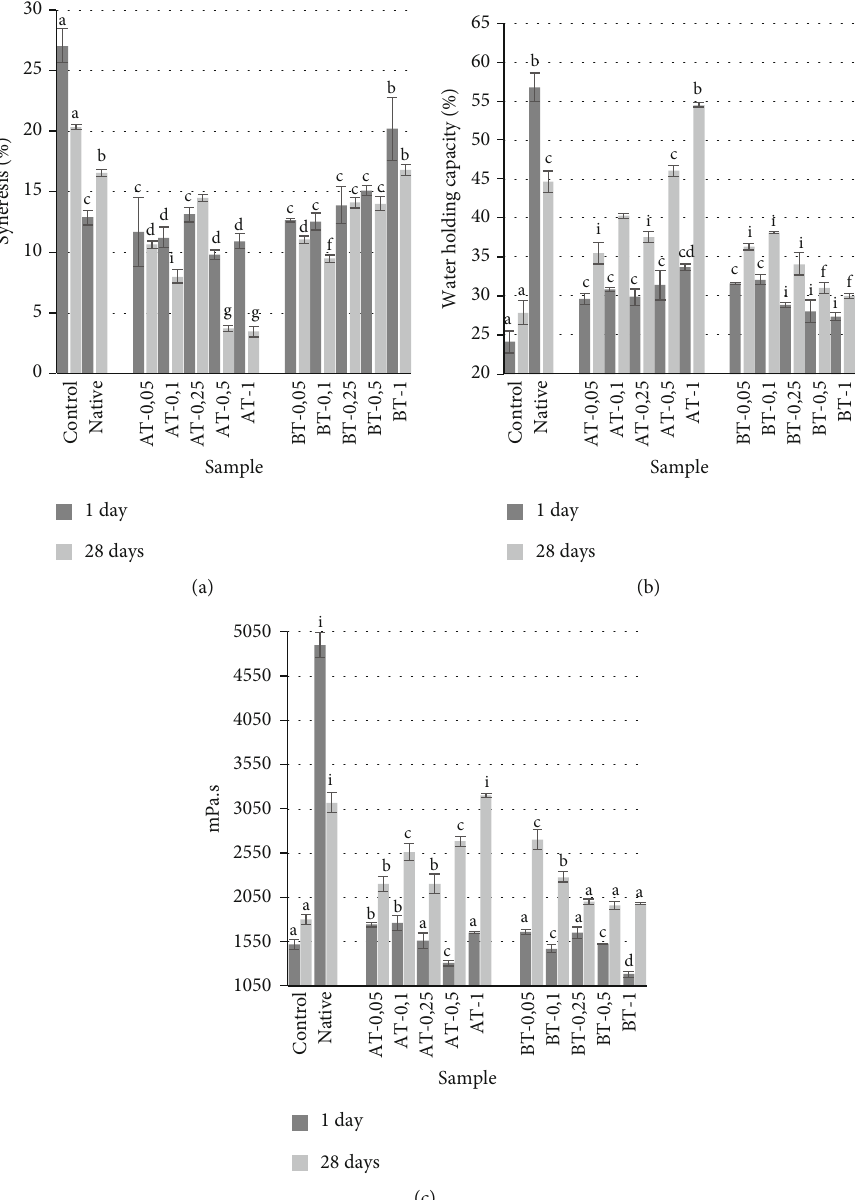
Figure 1: Syneresis (a) and WHC (b) and apparent viscosity (c) of Symbilact samples with added di ff erent starches. Data are the mean ± standard deviation of three independent replicates ( N = 3 ). Di ff erent letters in the same column (after 1 or 28 days) indicate signi fi cant di ff erences ( P < 0 : 05